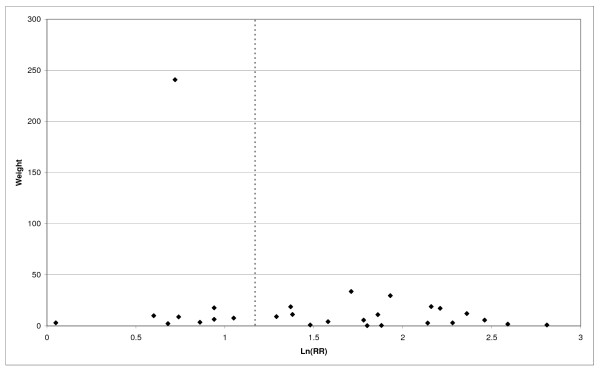
Funnel plot for ever smoking and emphysema. Funnel plot of the 28 relative risk estimates for ever smoking and emphysema included in the main meta-analysis in Table 5 against their weight (inverse-variance of log RR). The dotted vertical line indicates the fixed-effect meta-analysis estimate.